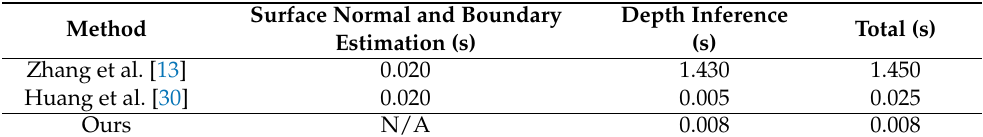
Table 4. The computational time (seconds) of the depth completion on the Matterport dataset. Note that the computational times of both Zhang et al. and Huang et al. were reported as the computational time of surface normal estimation and boundary estimation. Both of the above methods require the surface normals and boundaries to be extracted from the RGB image for depth inference. This step took 0.02 s (Huang et al. used the same method as Zhang et al. to estimate the surface normals and boundaries).